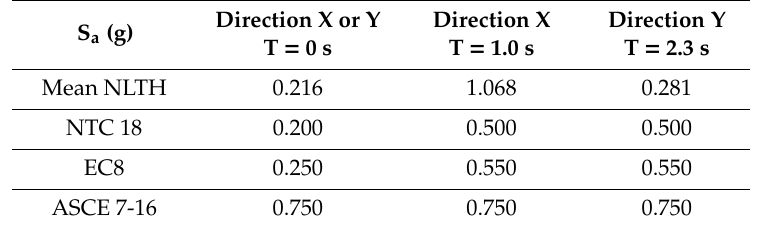
Table 7. Spectral absolute acceleration values for RP = 200 years for three periods of